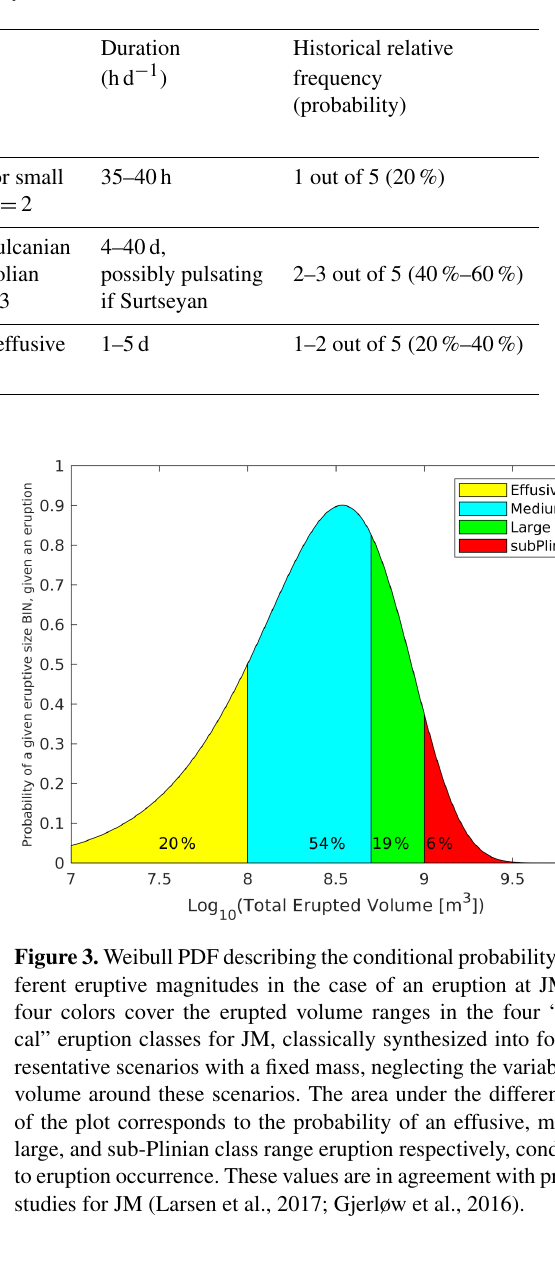
Table 1. Possible relative eruption scenarios on JM. The categorization is based on the volume of tephra emitted in DRE. Data obtained from Larsen and Guðmundsson (2016) and Gjerløw et al. (2016). According to the geological record (extending beyond the Holocene), sub-Plinian/Plinian events are highly unlikely (1%). Because of this, they are not included in this table.